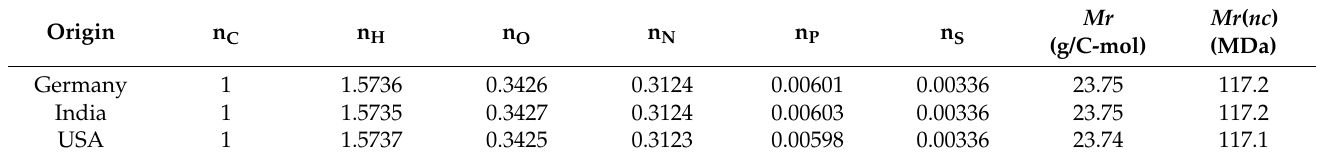
Table 1. Empirical formulas and molar masses of the SARS-CoV-2 Omicron BA.2.75 nucleocapsids.